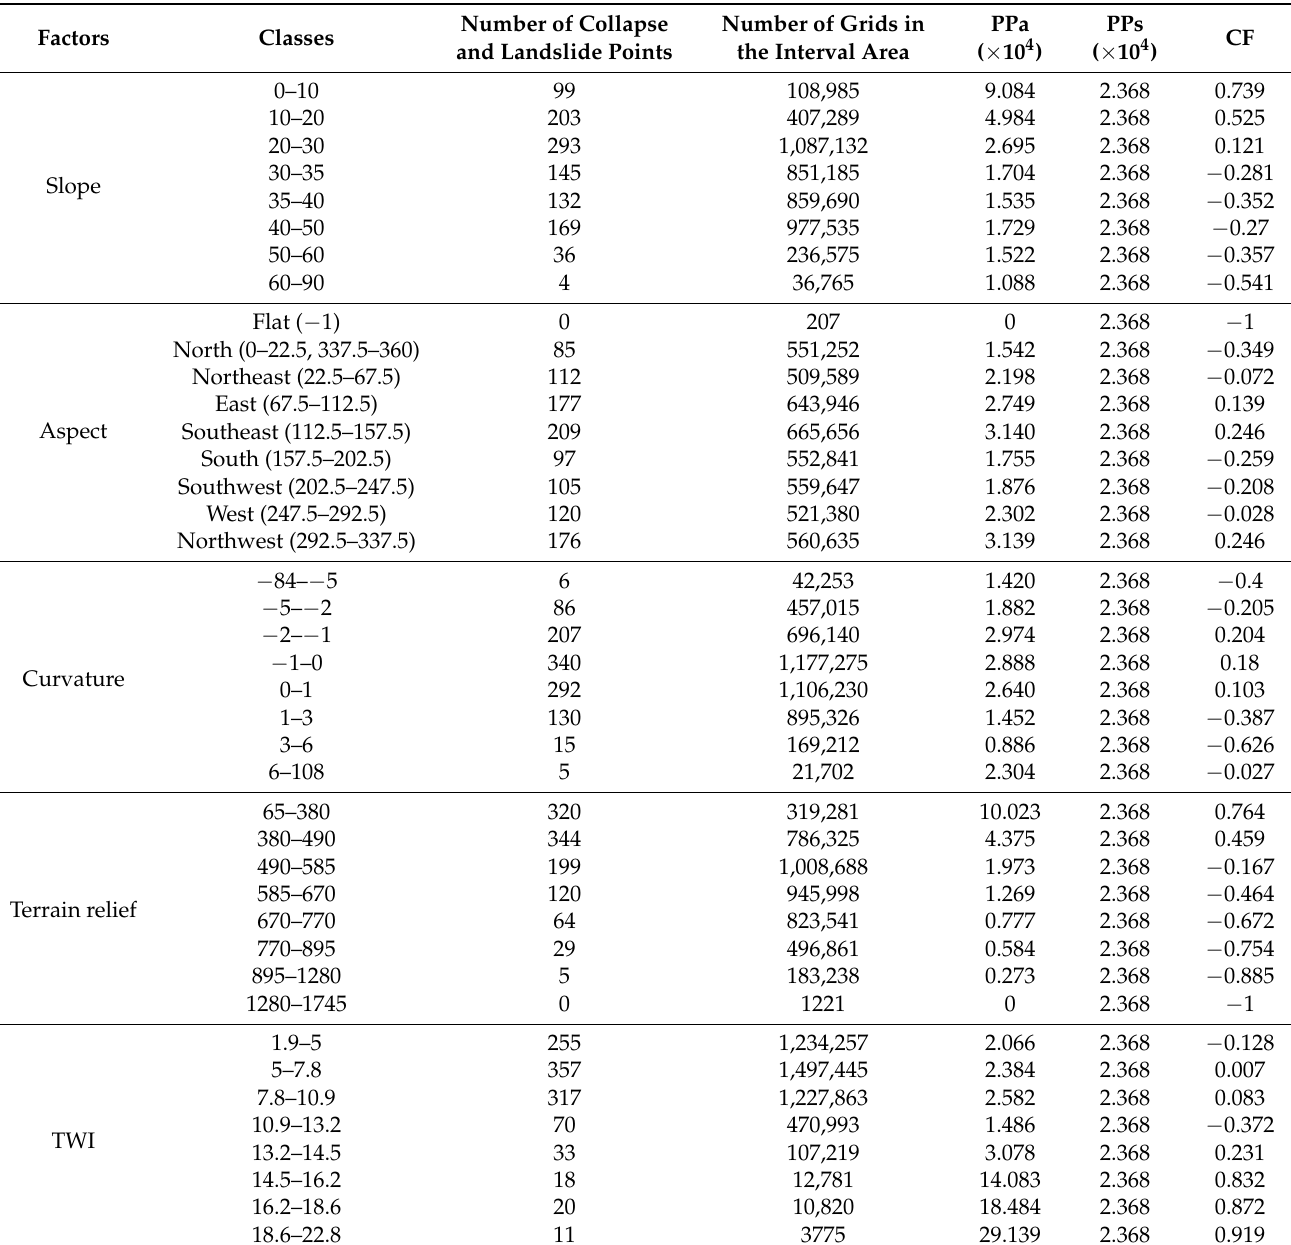
Table 6. Attribute interval classification and certainty factor value of environmental